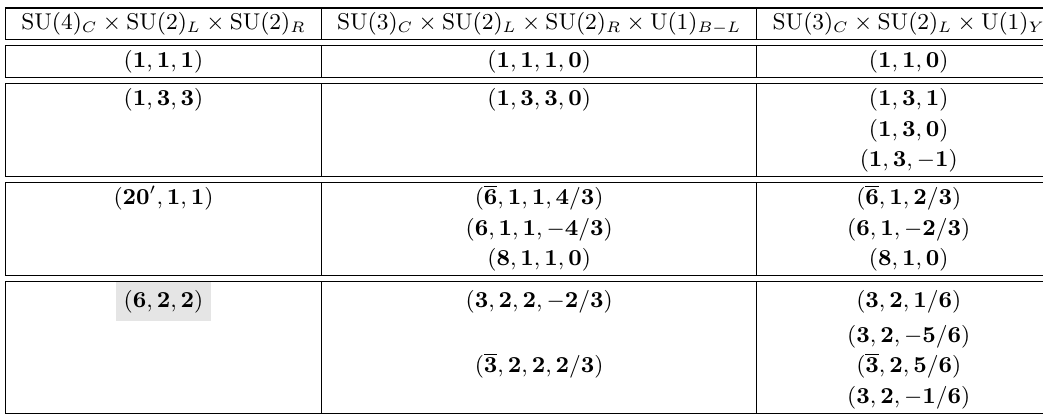
Table 9 . Decomposition of 54 -Higgs, which is a real field. Multiplets highlighted in red, blue, and green contribute to the RGE running of the gauge coupling in the energy scale in between SO(10) and G 422 , G 422 and G 3221 , and G 3221 and G 321 , respectively. Multiplets highlighted in gray represent the Goldstone bosons.